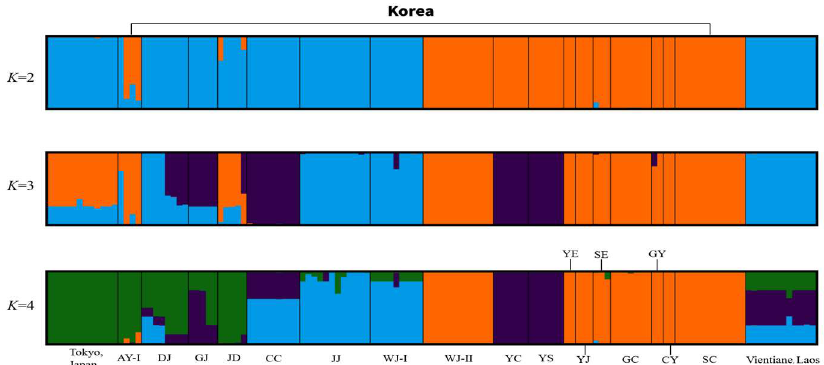
Figure 6. The bar plots of population structure generated by STRUCTURE software at K= 2–4. Different geographic locations are shown in STRUCTURE based on 16 microsatellite loci. The four distinct colors (orange, green, violet/purple, and sky blue) of each vertical solid bar denoting an individual/single population are also represented.